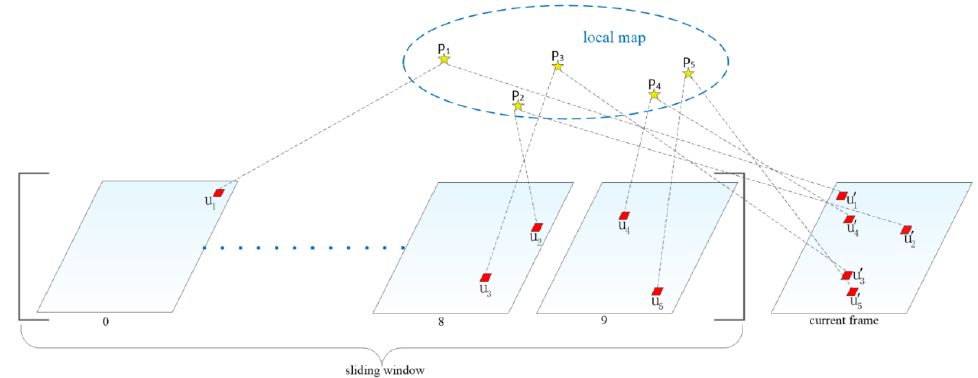
(cid:48) on the current frame to minimize the photometric i